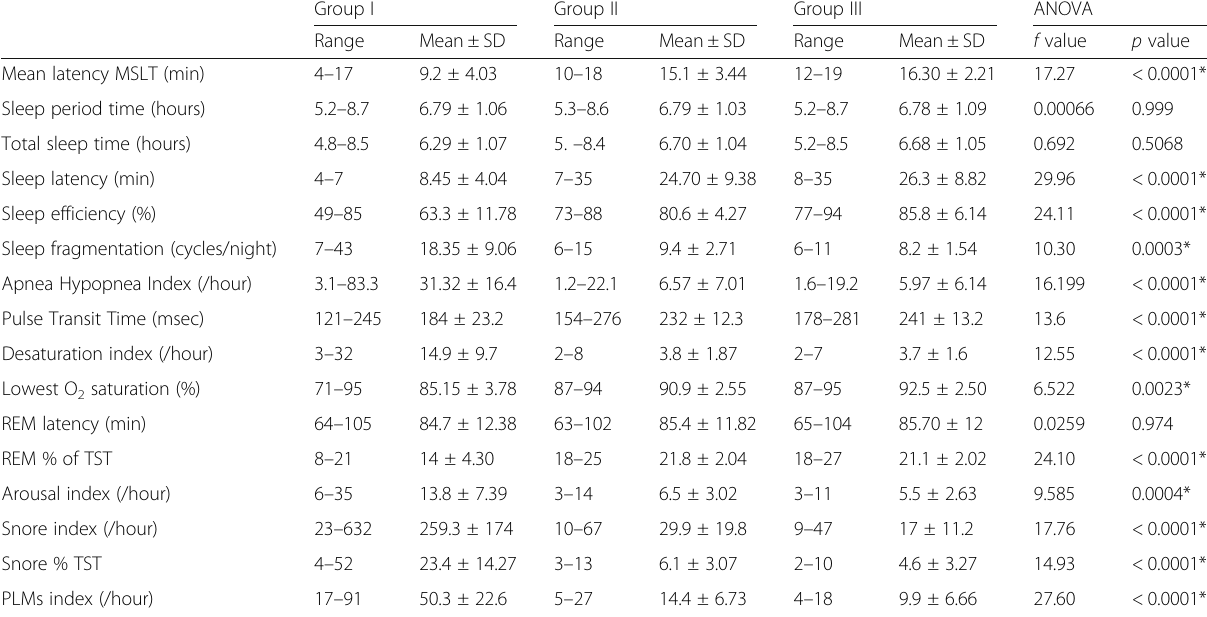
Table 2 Sleep parameters among diabetic neuropathy patients (group I), diabetic patients without neuropathy (group II) and healthy control (group III)